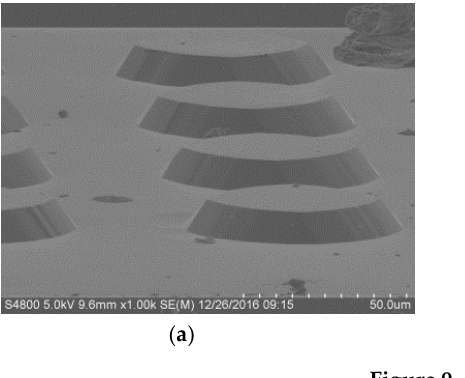
Figure 8. Three-step etching processing. ( a ) Oxide layer was grown on a single(100) Si; ( b ) The oxide layer was patterned to a 50 μm diameter circular mask; ( c ) a circular table was formed by wet etching; ( d ) the oxide layer was partly removed to form a 30 μm diameter concentric circular mask; ( e ) the wafer was cut to form edge’s angle; ( f ) the rest of the oxide layer mask was removed; ( g ) a third etching was performed to form final shape.